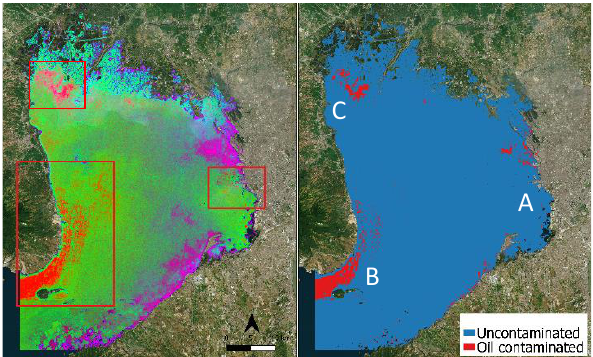
Figure 8. A multi-band composite for Manila Bay is created (left) after application of the PCA transformer developed for mapping oil spill in Iloilo Straight. The red coloration corresponds to oil-like features. A binary image showing the oil contaminated and uncontaminated areas is shown in the